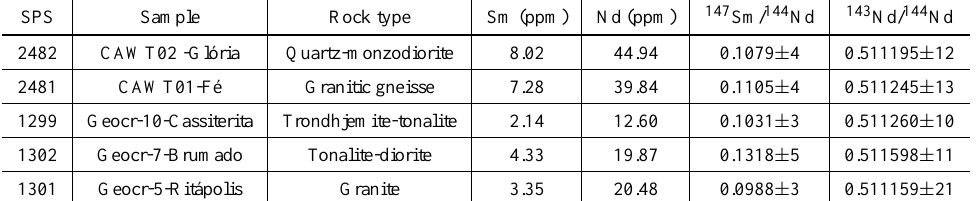
Sm-Nd whole rock analytical data of sample CAWT02 (PC-18E – M-II facies) of Glória quartz- monzodiorite, and of four neighboring plutons. ε Nd(T) values were calculated according to the crystallization age of the Glória quartz-monzodiorite. See text for